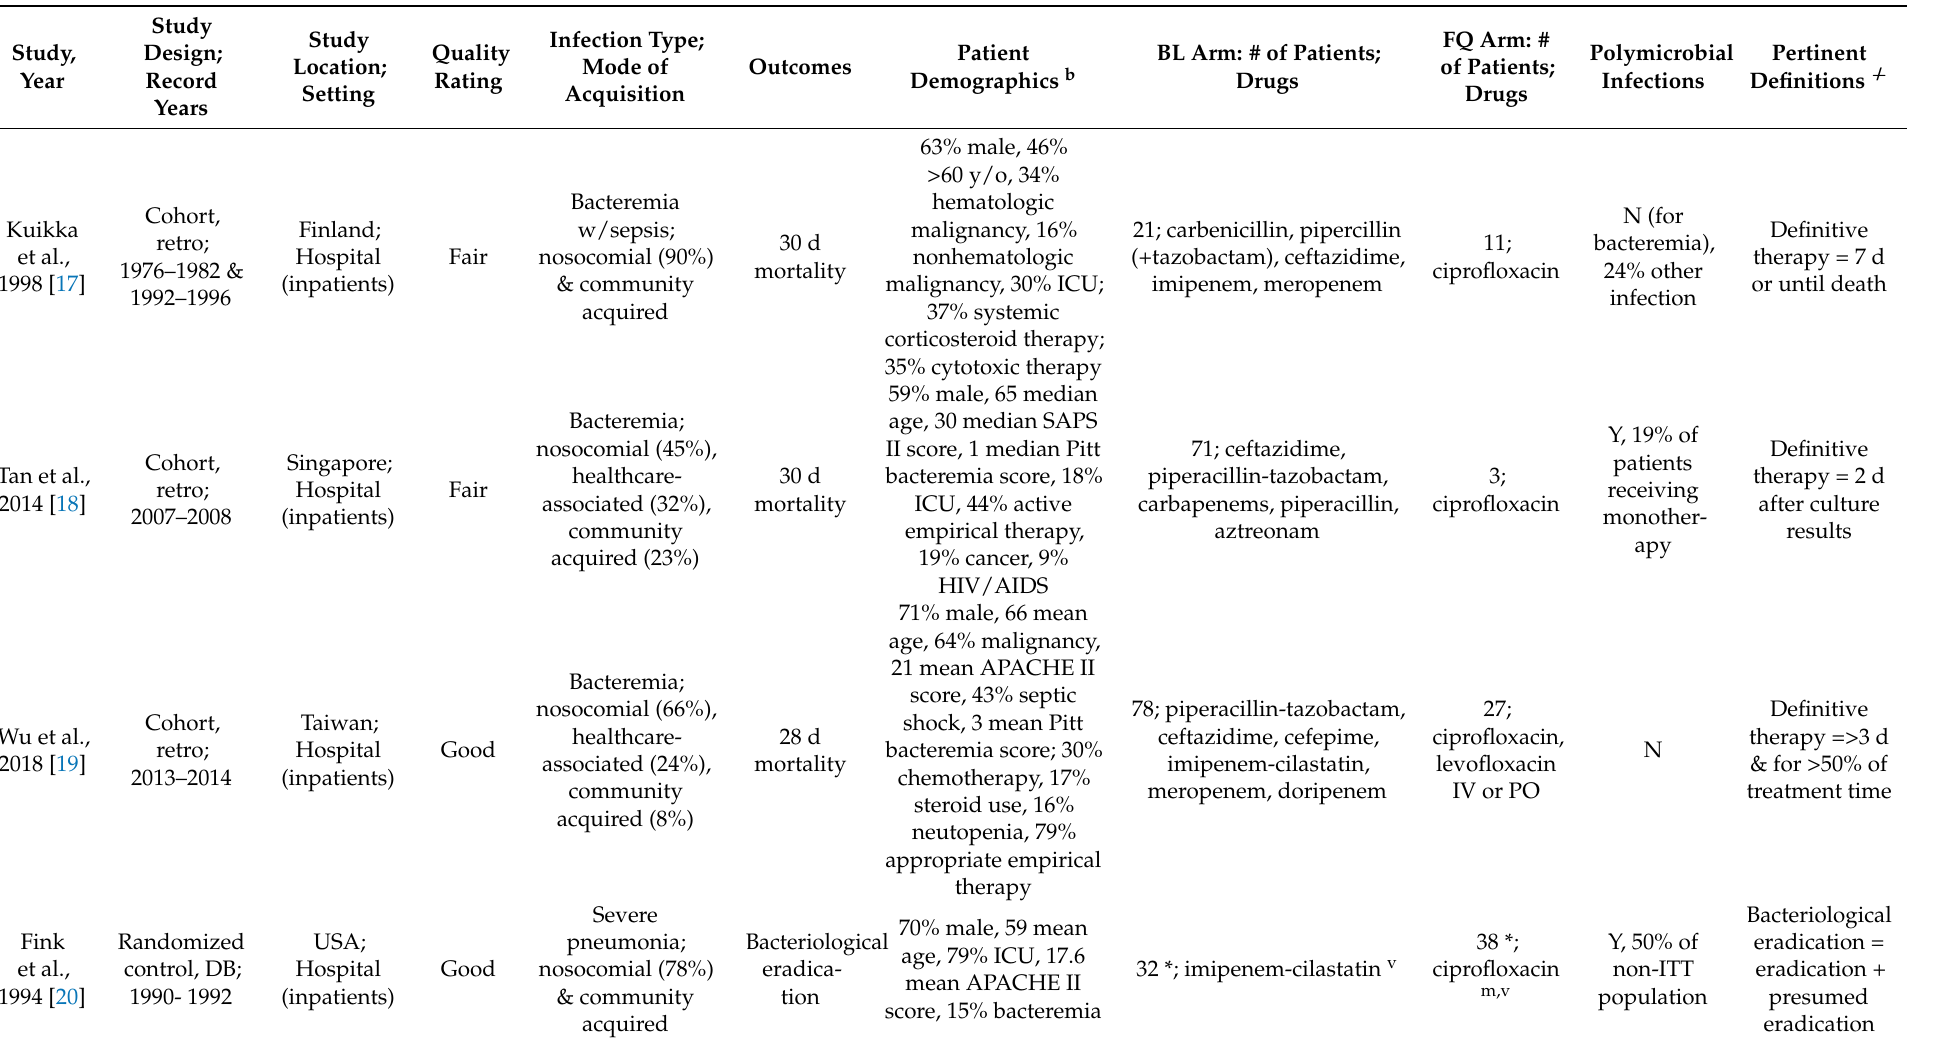
Table 1. Characteristics of selected